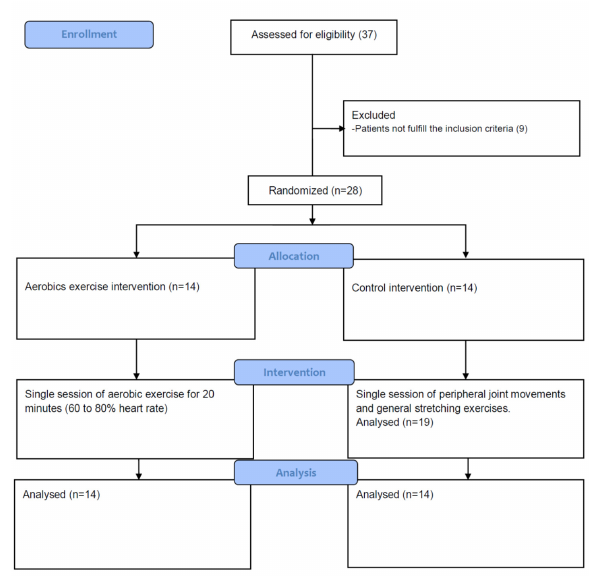
Figure 1. Study flow diagram.